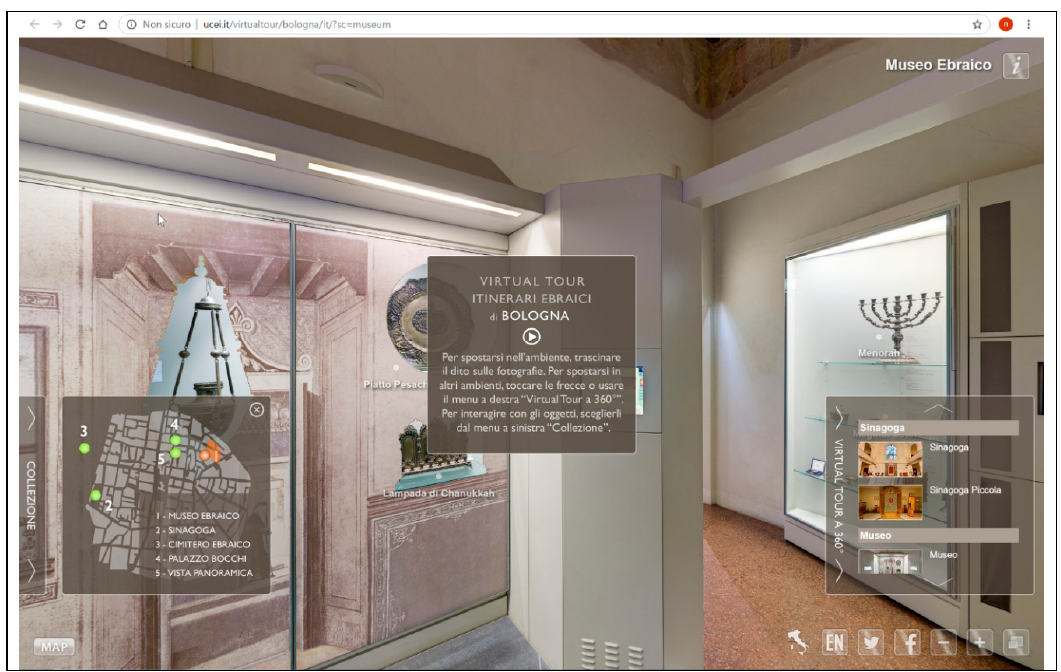
Figure A8: “Virtual Tour Itinerari Ebraici di Bologna—Museo Ebraico”. Command bar, scenes preview (on right), objects preview (show/hide on left), link among scenes, information window, map, social media [30].